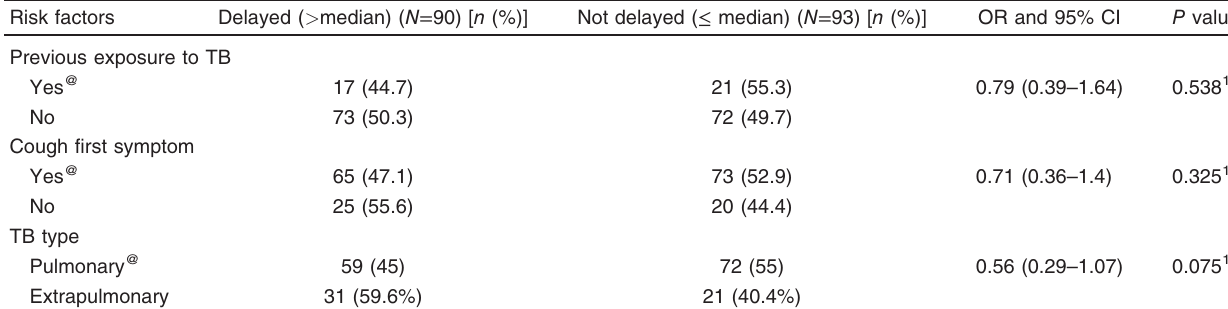
Table 4 Risk factors for total delay among the studied patients (previous exposure to tuberculosis, cough first symptom, and tuberculosis type) ( N = 183) Risk